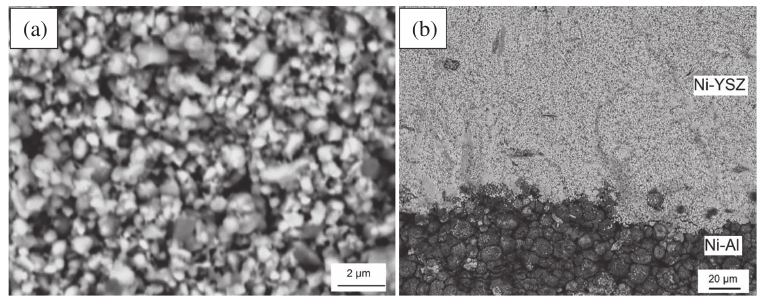
Figure 7: The surface (a) and cross-section (b) of NiO-YSZ layers after sintering by SPS in Ar at 1,100°C for 10 min and reduction in hydrogen at 800°C for 2